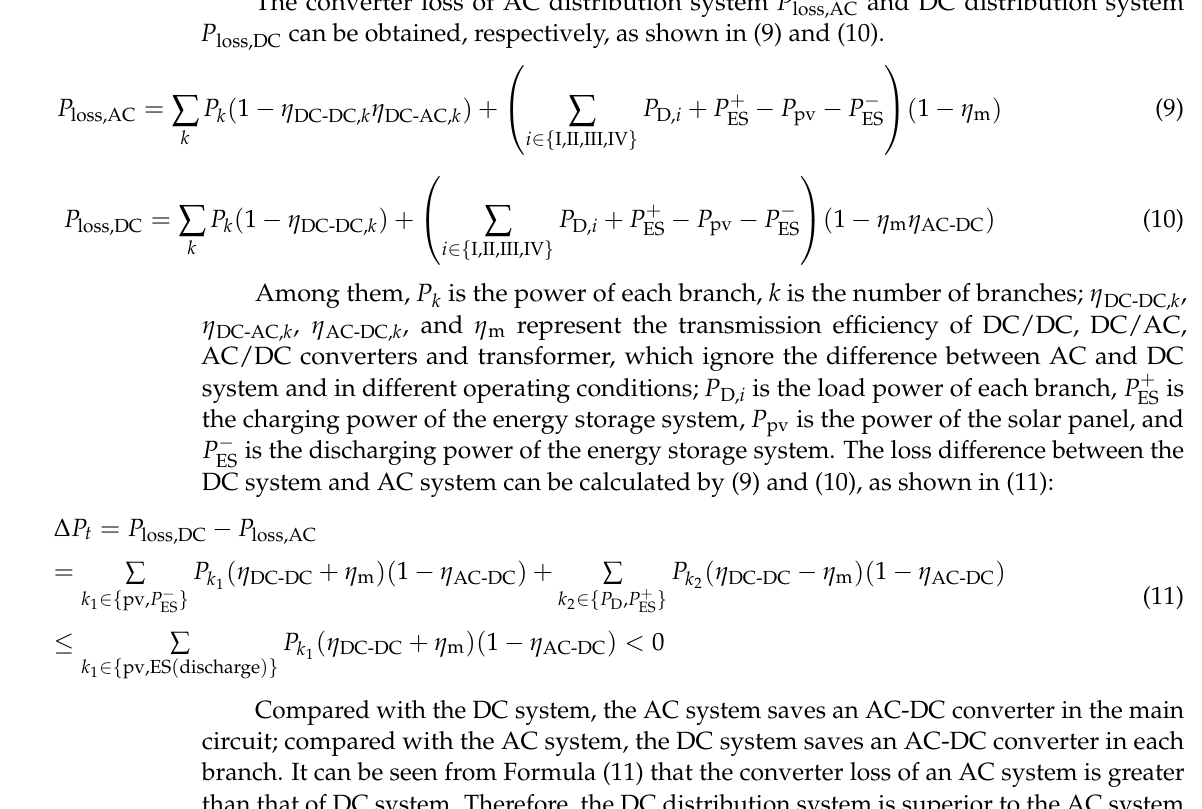
Figure 4. The real-time energy flow of NZEB.